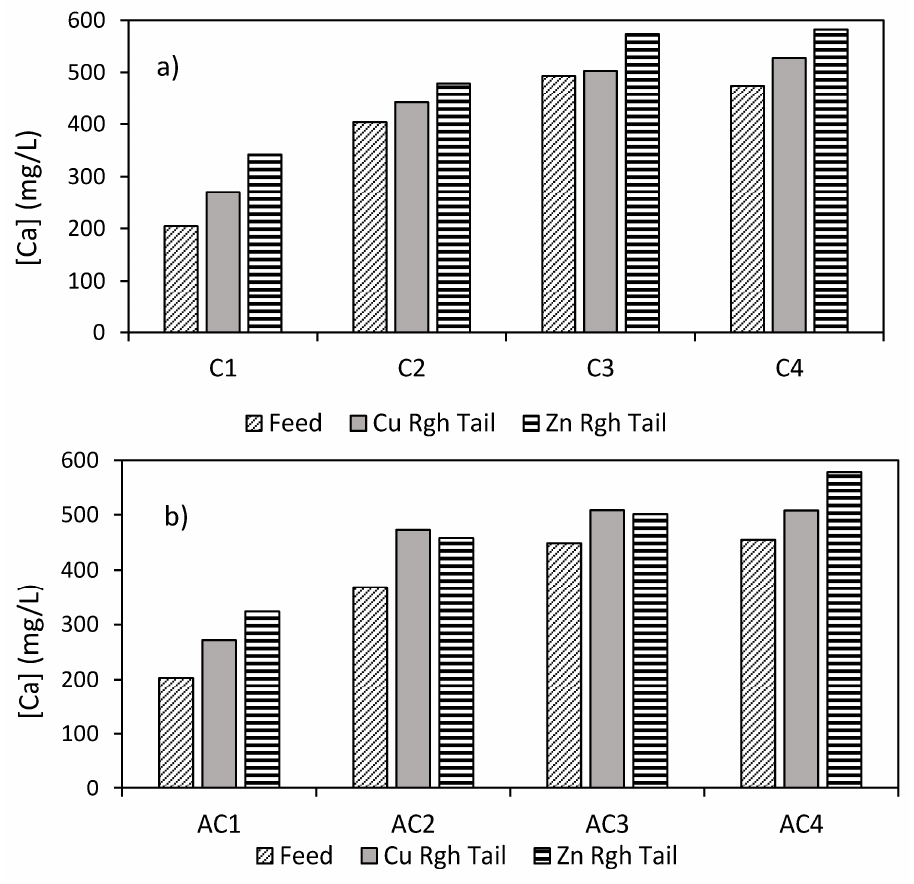
Figure 8. Dissolved ion concentration of calcium ions at different stages of flotation tests during water recirculation without ( a ) and with ( b ) treatment.